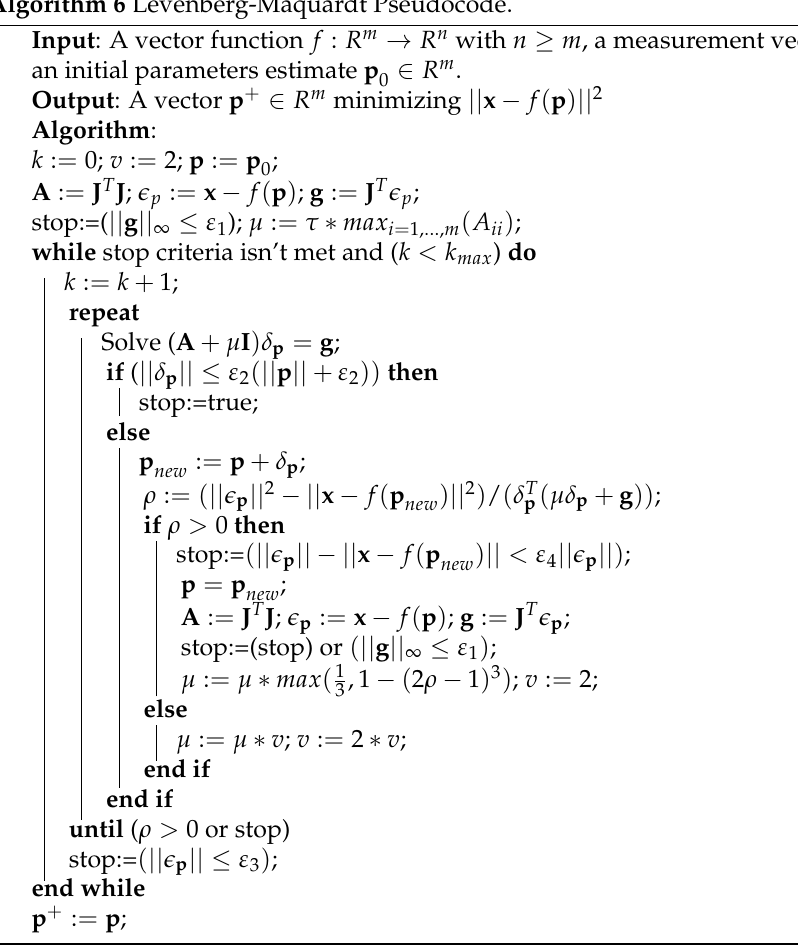
Algorithm 6 Levenberg-Maquardt